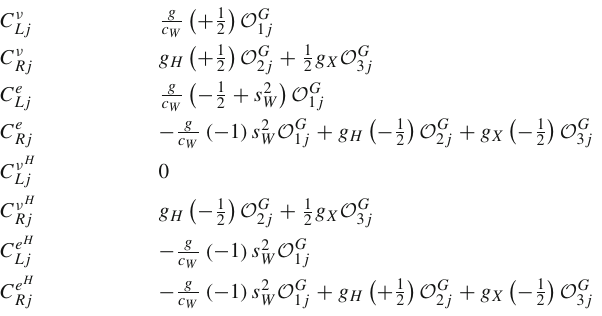
and C f for leptons Lj Rj